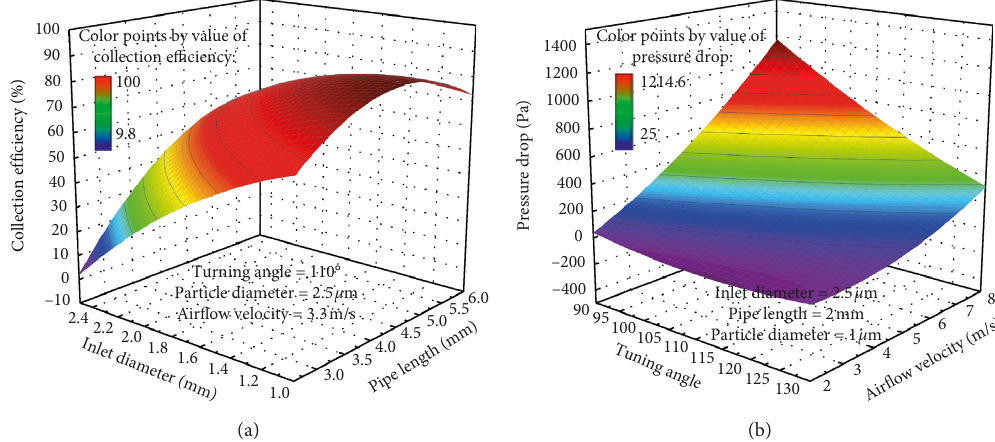
Figure 8: (a) Collection efficiency versus inlet diameter and pipe length; (b) pressure drop versus turning angle and airflow